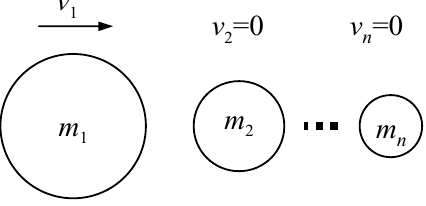
Fig. 5. System of sequentially smaller, stationary masses impacted by a moving